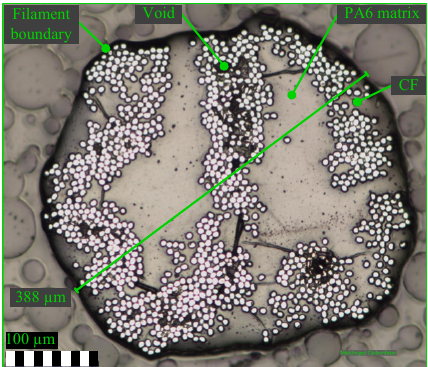
Figure 5. Microscopic image of an unprinted CF/PA6 filament cross-section showing an irregular distribution of continuous fibres in three bundles, and areas of pure matrix material in between.